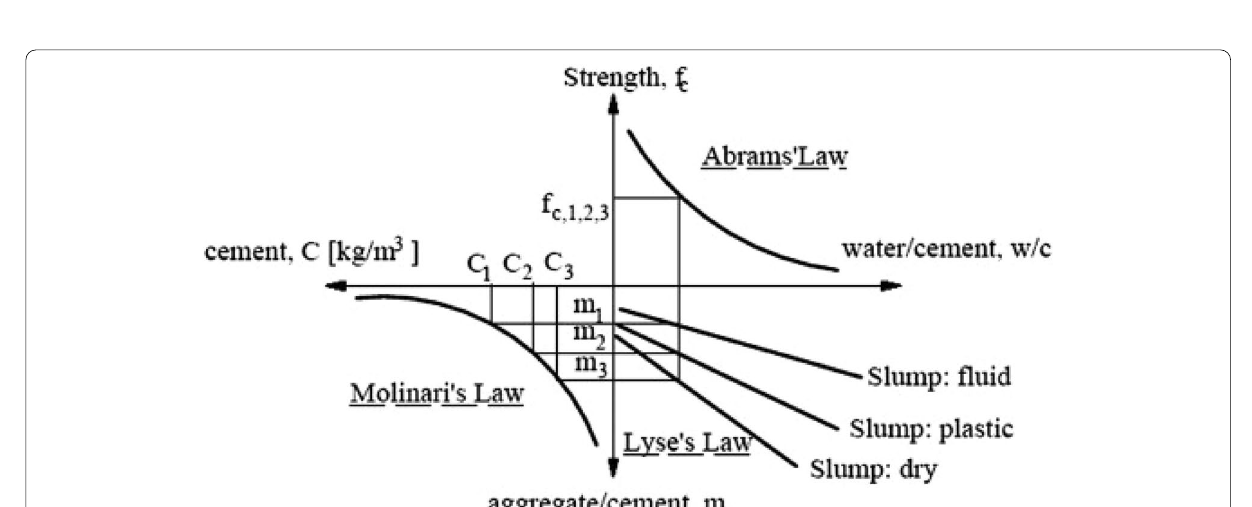
Fig. 3 Mix design nomogram of water-to-cement ratio in relation to compressive strength as design criterion (Alyamaç & Ince, 2009; Monteiro et al., 1993).